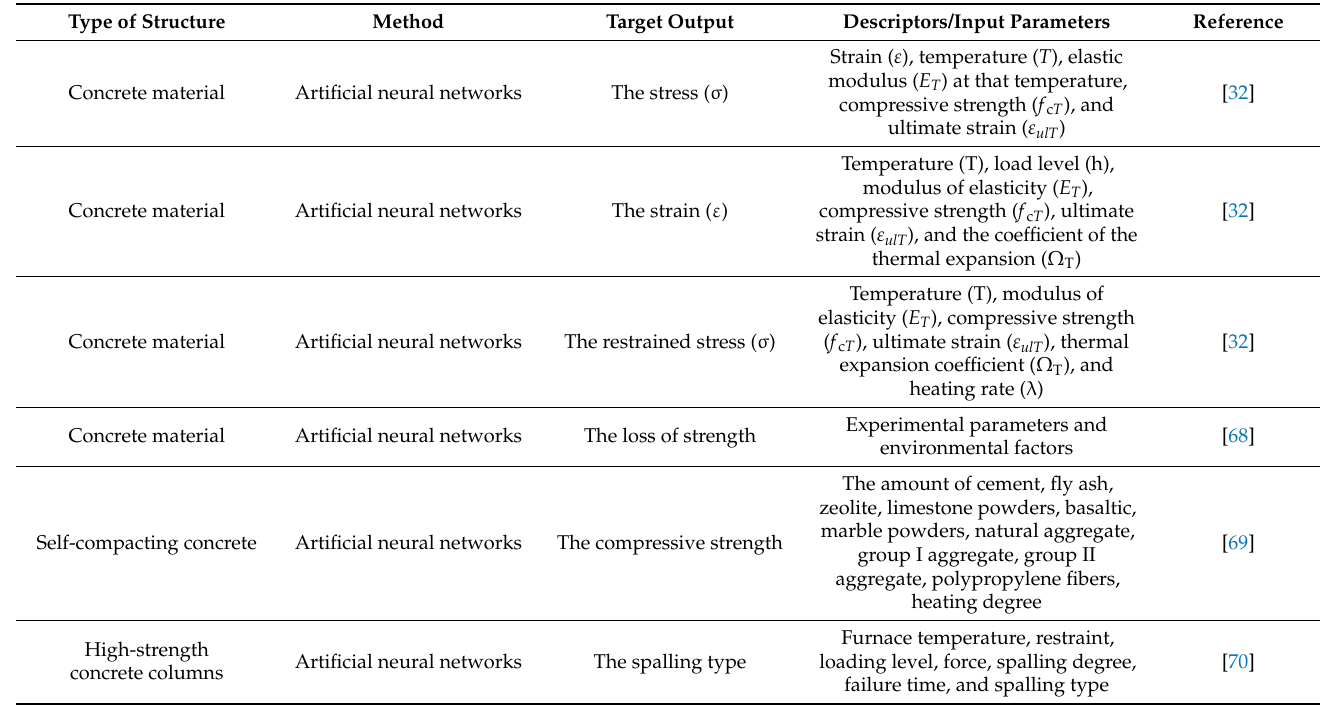
Table 1. Typical descriptors used in artificial intelligence (AI)/ML (machine learning) models to predict the fire-induced properties of some types of structural